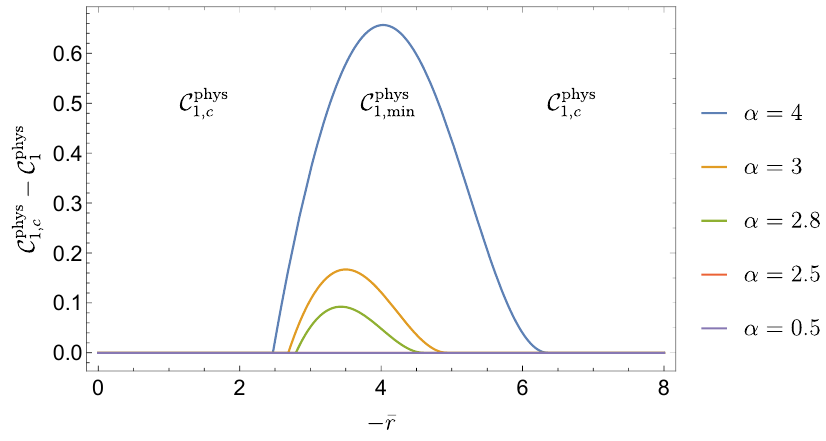
Figure 3 . The di(cid:11)erence between the complexity obtained for (cid:18) c at the intersection of cases (a) and (c) and the exact puri(cid:12)cation complexity of one-mode Gaussian states in the physical basis C phys (^ (cid:26) 1 ) (cid:0) C phys (^ (cid:26) 1 ) as a function of (cid:22) r for some (cid:12)xed values of (cid:11) . We see that the complexity 1 ;c 1 obtained at the intersection between cases (a) and (c) with C phys optimal for some region of the parameter (cid:22) r for large enough values of (cid:11)